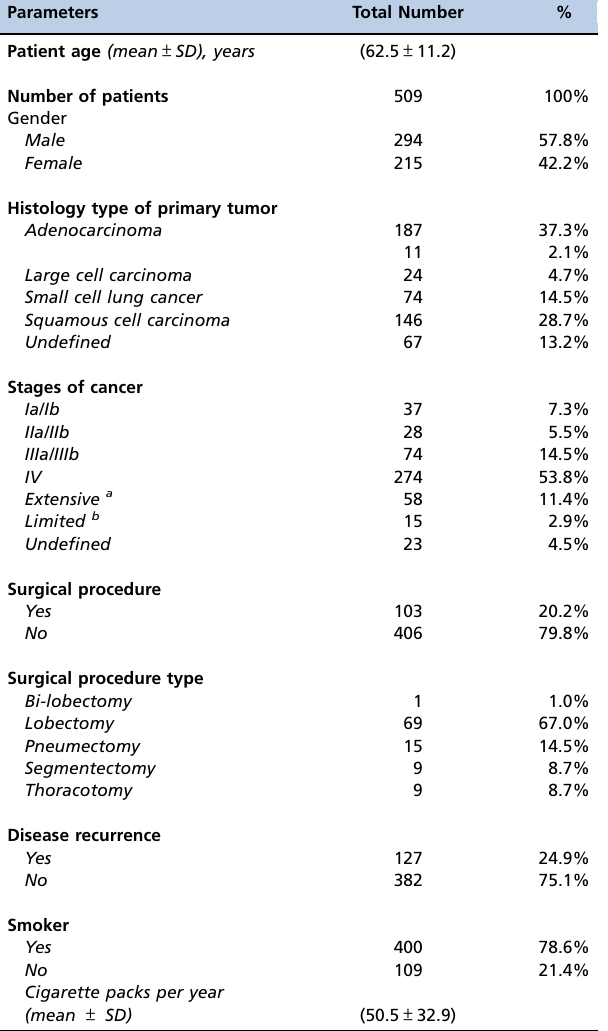
Table 1 - Demographic characteristics of the 509 lung cancer patients.